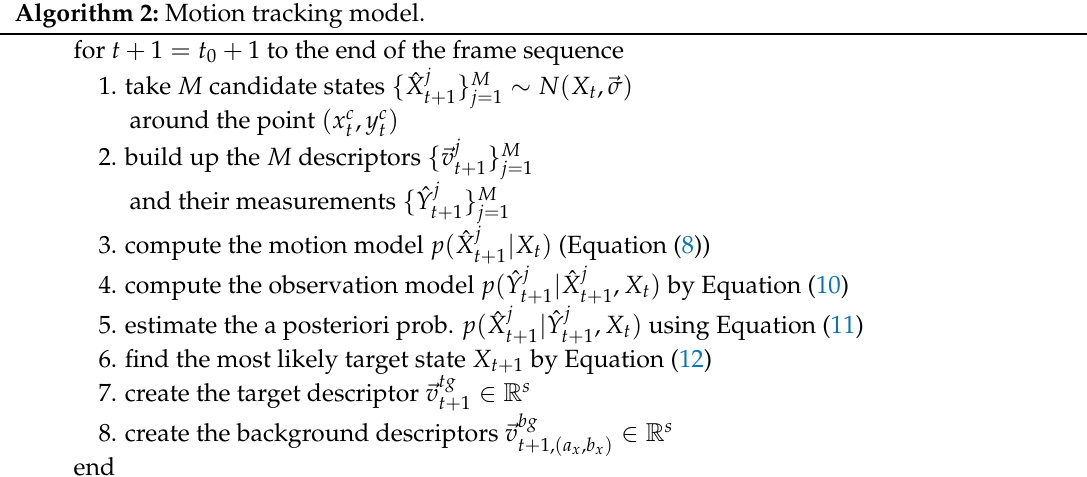
Algorithm 2: Motion tracking